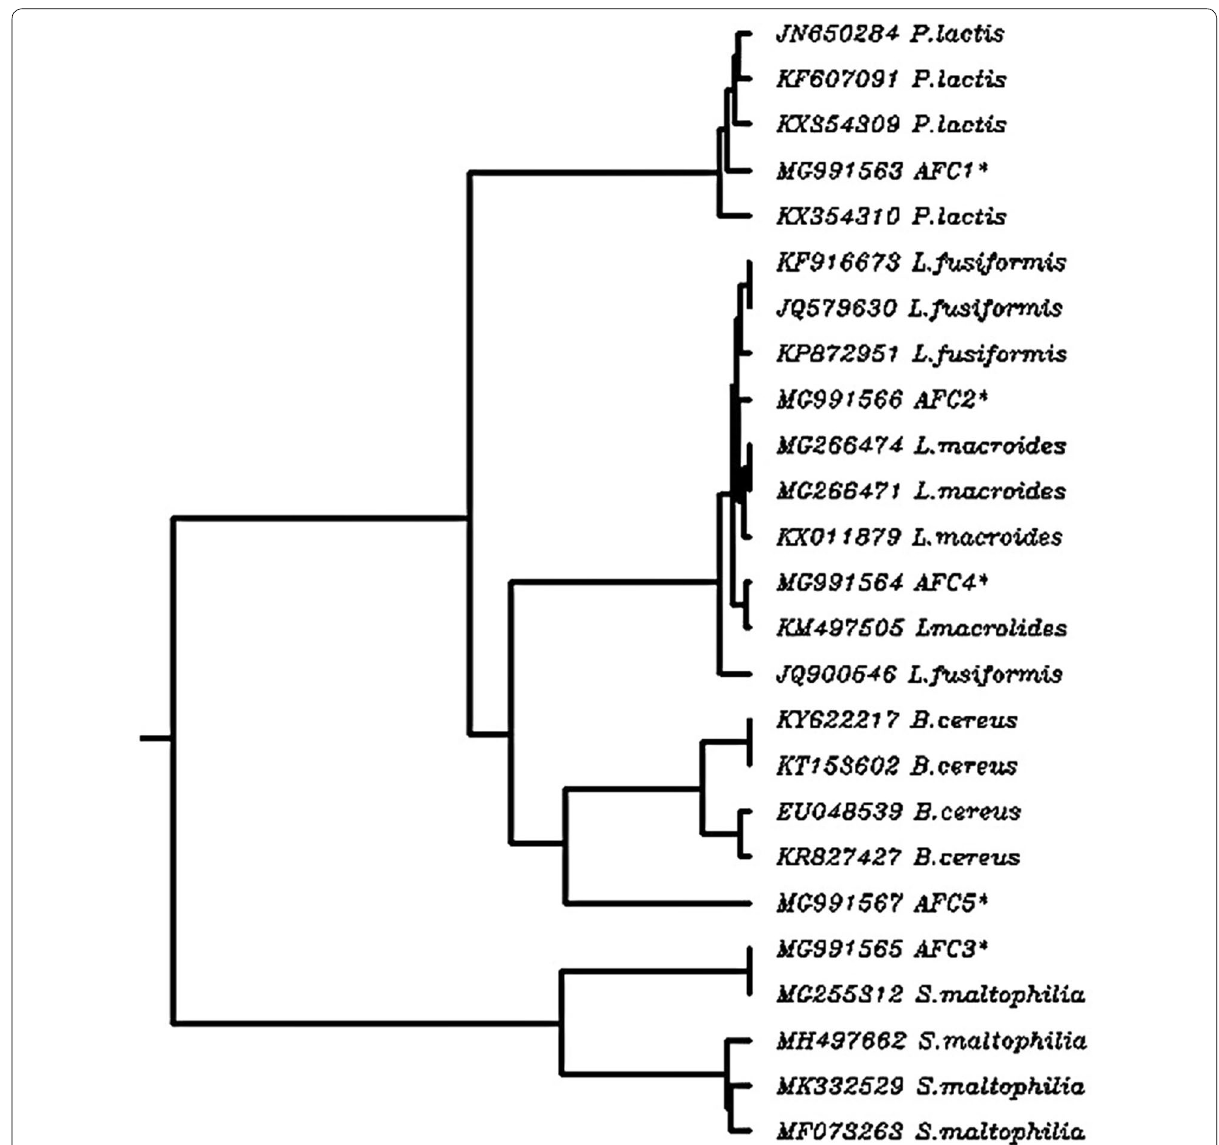
Fig. 4 Phylogenetic tree showing the relationship between the five strains and the closely members of bacterial strains obtained from NCBI database according to 16s rDNA gene